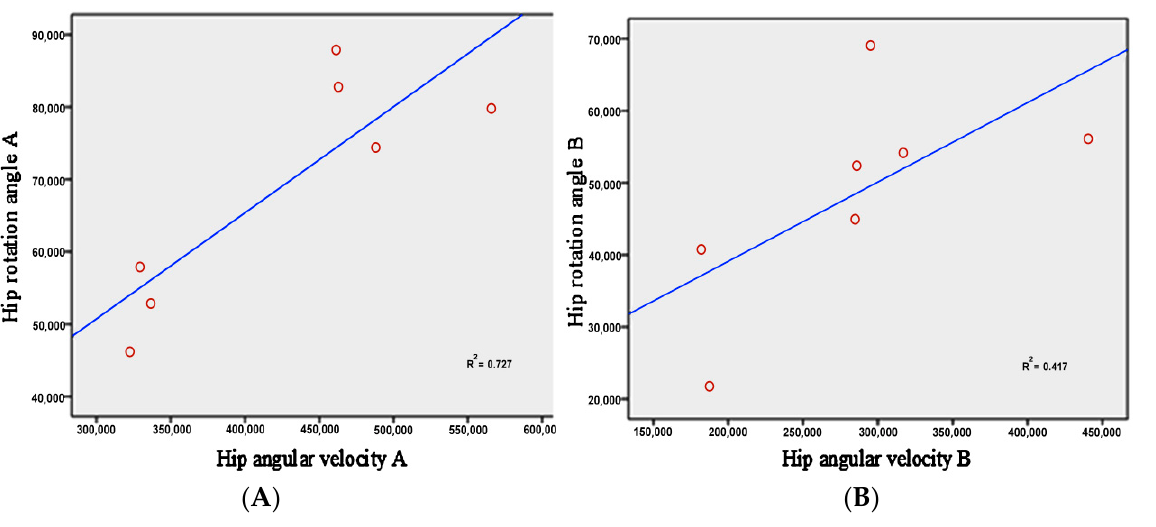
Figure 10. Correlation comparison of the hip angular velocity and hip rotation angle. ( A ) is the master group; ( B ) is the beginner group.